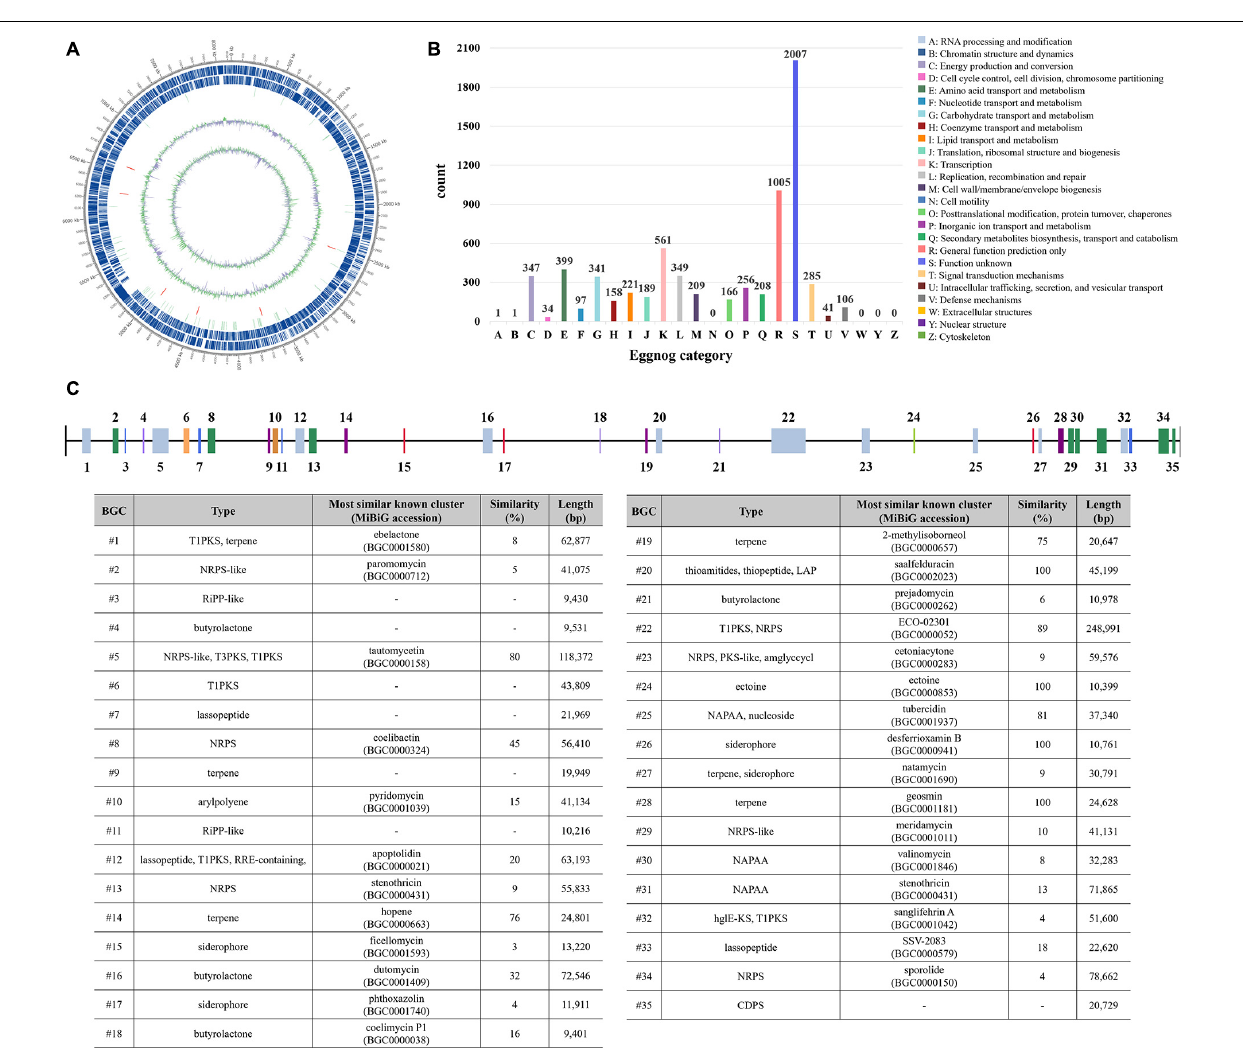
Amphotericin B and Nystatin A1 ( Supplementary Figure 7